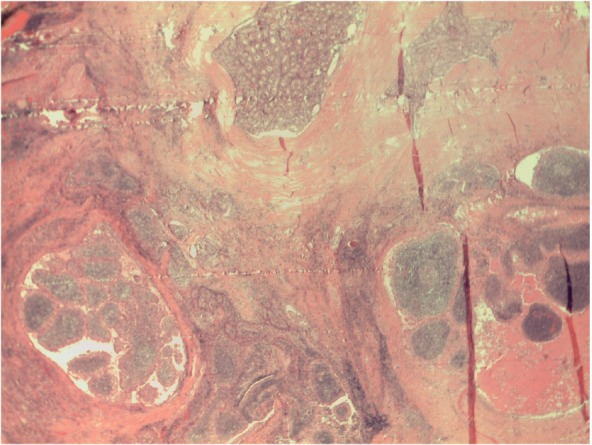
Landscape of papillary carcinoma with two components: bottom left the Warthin-like and upper middle-right the sclerosing ones.